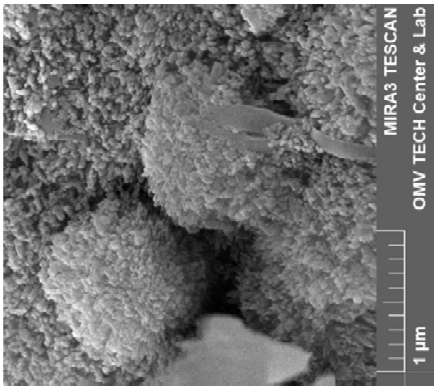
Figure 19. Scanning electron microscopy (SEM) image. Nanomaterials were also observed to adsorb